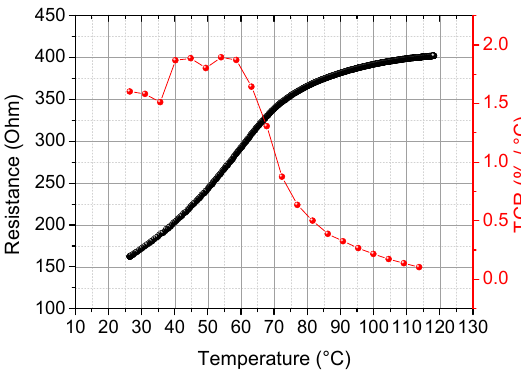
Figure 1. Electrical Resistance vs Temperature characteristics of a 100 nm thick LSMO film in the 25–120 °C temperature range ( left ) and respective calculated TCR ( right ).